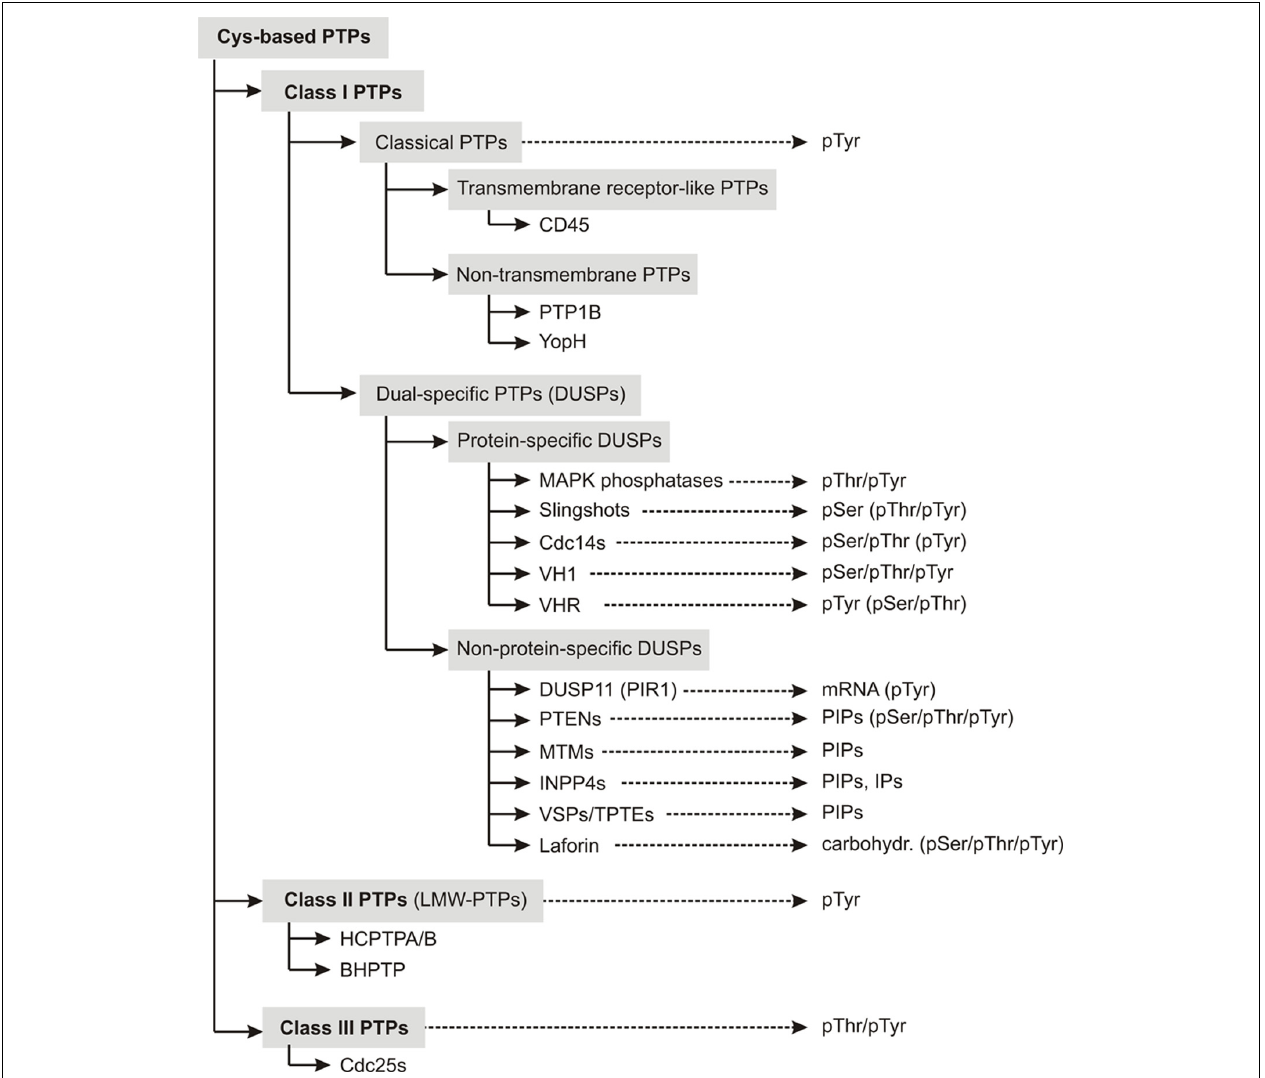
FIGURE 1 | Overview about the classification scheme of cysteine-based PTPs. Members of individual subfamilies, which were exemplarily chosen and discussed in the main text, are listed in their respective PTP subclass.The